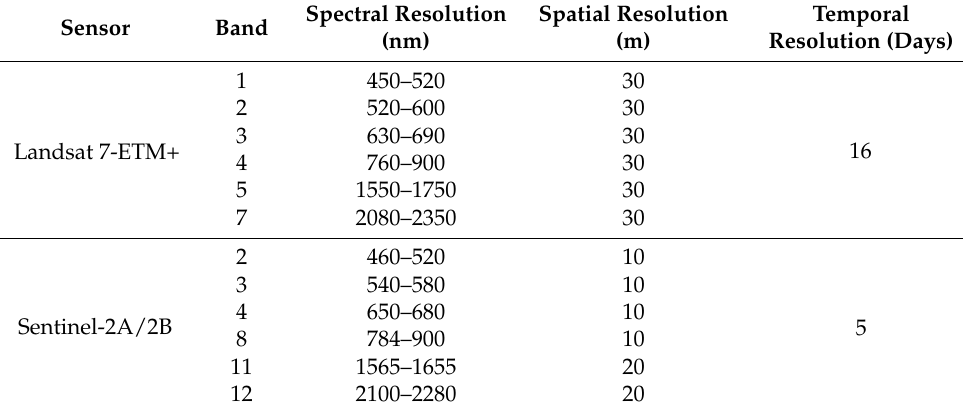
Table 3. Main features of Landsat-7 ETM+ and